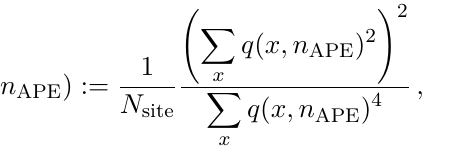
that points gradually accumulate on integer values of Q by “increasing” or